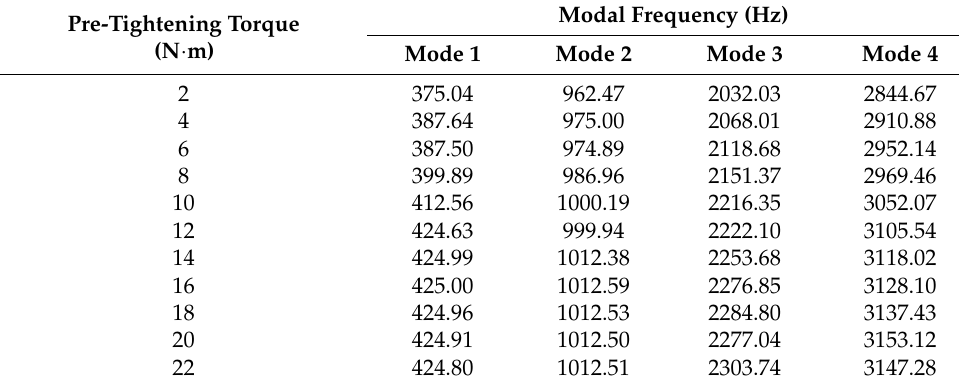
Table 4. Experimental modal frequency under different pre-tightening